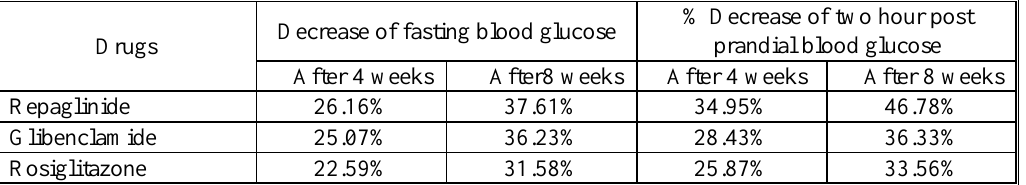
Table 4 : Percentages decrease of fasting and 2 – hours postprandial blood glucose in group1 , 2 and 3 of diabetic patients after 4 and 8 weeks of